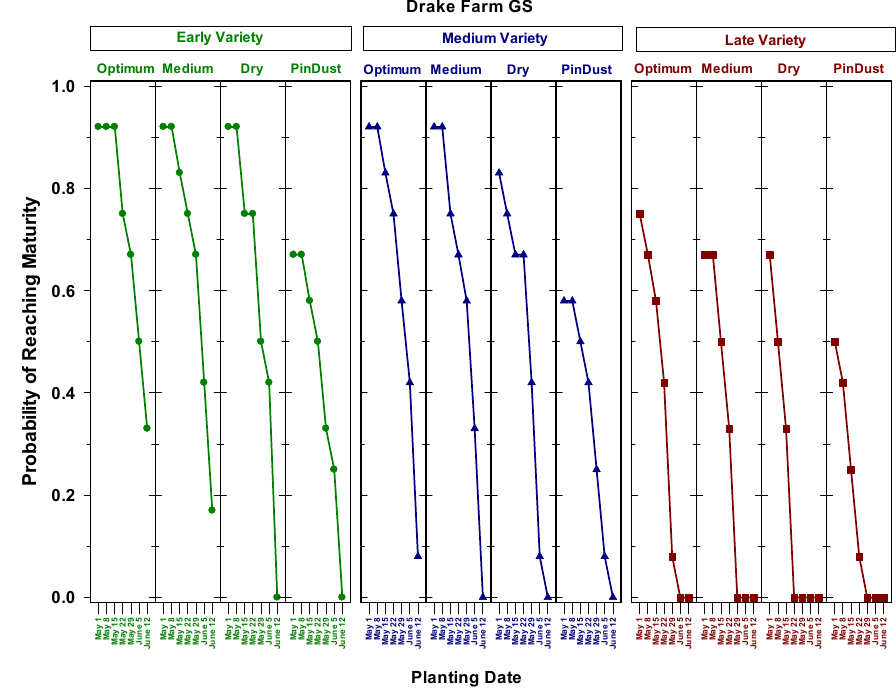
Figure 7. Probability of sorghum reaching physiological maturity at Drake Farm, Colorado, for seven planting dates using non ‐ stressed (GS) phenological parameters, three maturity classes, and four seedbed water conditions at planting.